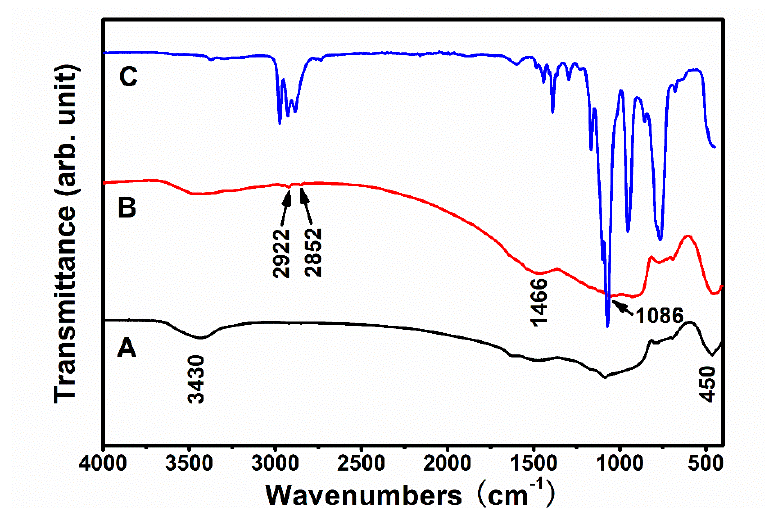
Figure 5. FTIR spectra of the glass fiber (A) before and (B) after the modification and (C) the silane coupling agent KH-550.